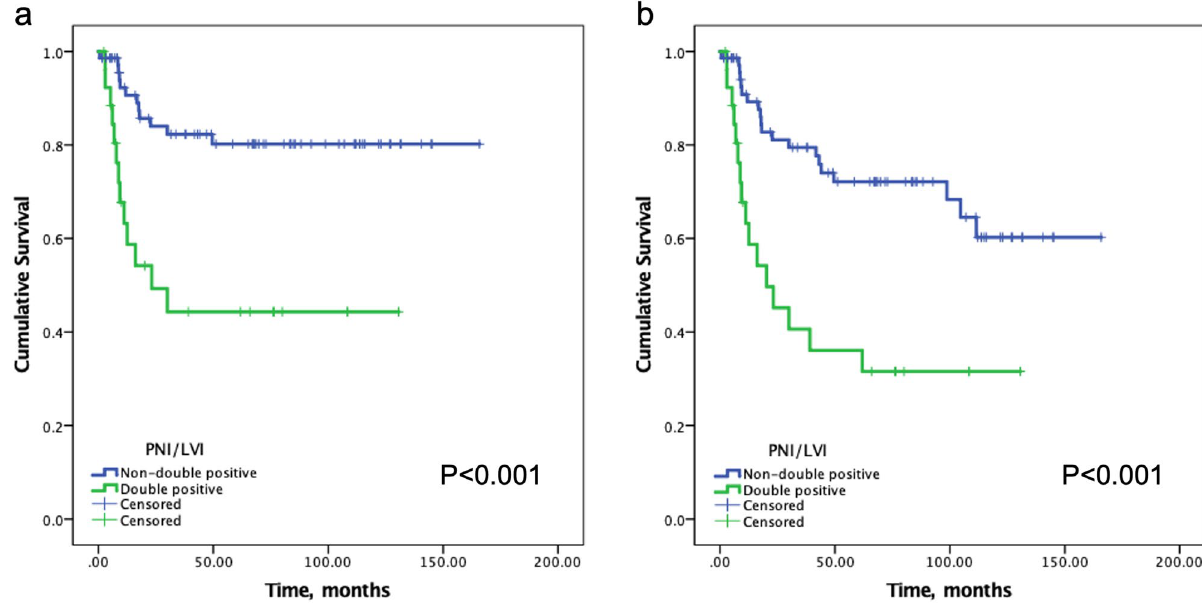
Figure 1. ( a ) Disease-specific survival curves for PNI/LVI double-positive and non-double-positive groups. ( b ) Overall survival curves for PNI/LVI double-positive and non-double-positive